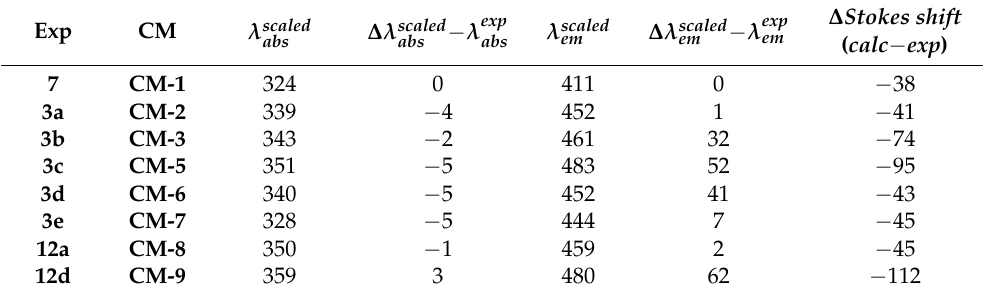
Table 8. Comparison between the experimental and calculated spectral characteristics. Scaling factor for the absorbance—1.098 and 1.195—for the